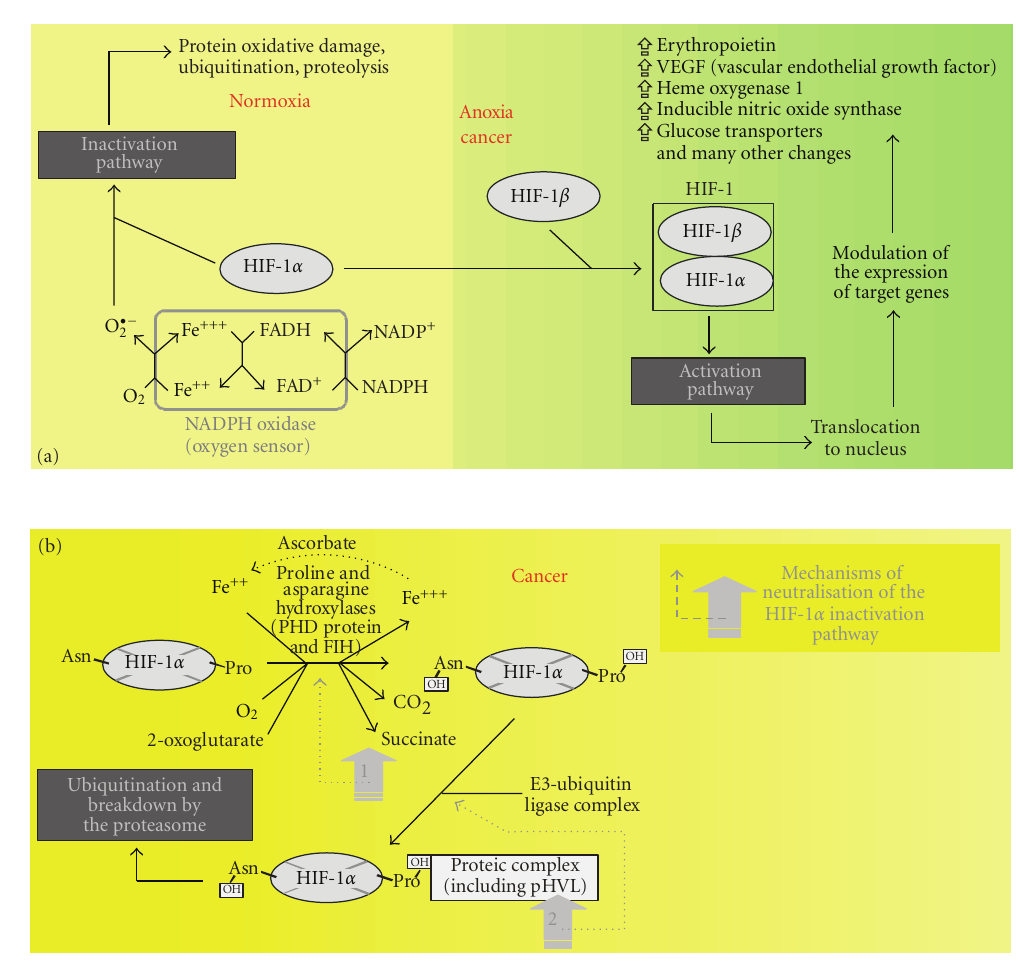
Figure 2: Activation and inactivation pathways for hypoxia-induced factor 1 (HIF-1) in normoxia, hypoxia/anoxia, and cancer. (a) In nor- moxic normal cells, molecular oxygen (O 2 ) sensing by membrane NADPH oxidase results in formation of superoxide radical anions and subsequently in the control of the HIF-1 signaling pathway via proteolytic degradation of the HIF-1 α subunit. These events prevent the re-cruitment of functional HIF-1 which results from heterodimerization of HIF-1 α and β subunits. In anoxia/hypoxia, a severe drop in the levels of NADPH oxidase-driven superoxide radical anion prevents oxidative and proteolytic damage of the HIF-1 α subunit which then becomes available to form functional HIF-1 and results in signaling activation. In cancer cells, the HIF-1 signaling pathway may be overex- pressed via, for instance, mechanisms illustrated in Panel b. (b) This panel details hydroxylation and the subsequent steps of the HIF-1 in- activation pathway and its disruption in cancer cells. Mechanisms that neutralize the HIF-1 pathway in cancer cells may include alteration of gene expression for succinate dehydrogenase and fumarase (the net results of which are a rise in succinate levels which interfere with the hydroxylation steps by product inhibition) (mechanism 1) and for von Hippel-Lindau protein (mechanism 2) (preventing formation of E3-ubiquitin ligase proteic complex and hence HIF-1 α inactivation). Other comments are in the